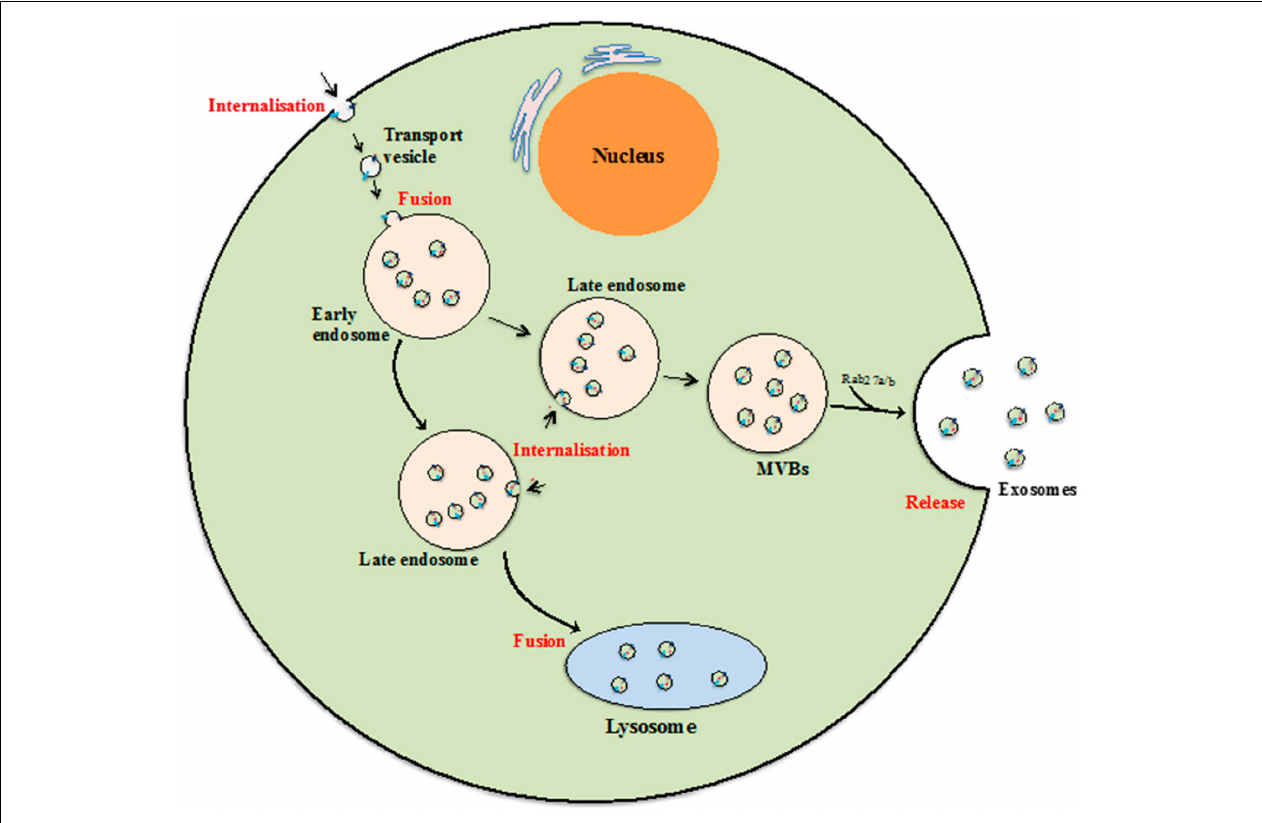
FIGURE 2 | Exosome biogenesis. Beginning from internalization of membrane proteins and lipid complexes by endocytosis, endocytotic vesicles are delivered to early endosomes, which fuse with each other resulting in formation of late endosomes/multivesicular bodies (MVB). [Adopted from Than et al. (2017) distributed under the Creative Commons Attribution